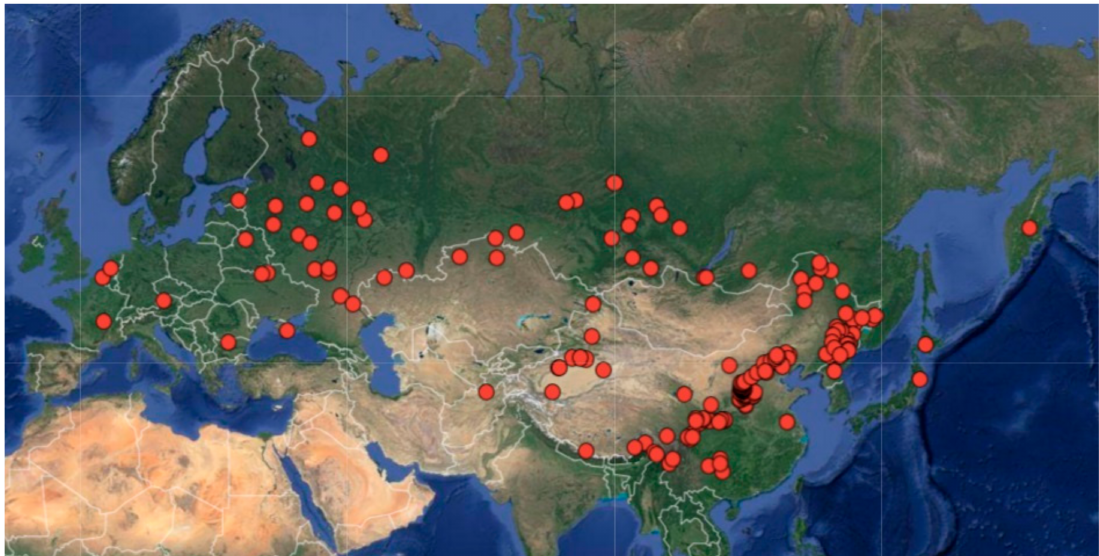
Figure 1. Allocation of sample plots with biomass (t / ha) determinations of 413 Populus forest stands in the territory of Eurasia. Table 1. Distribution of plots with determinations of Populus biomass (t / ha) by species and countries. Species Botanical Name Country Plot Quantity Quaking aspen Populus tremula L.